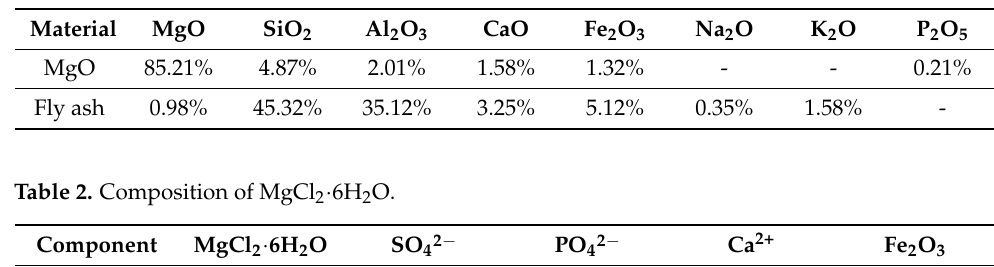
Table 1. Composition of fly ash and magnesium oxide.